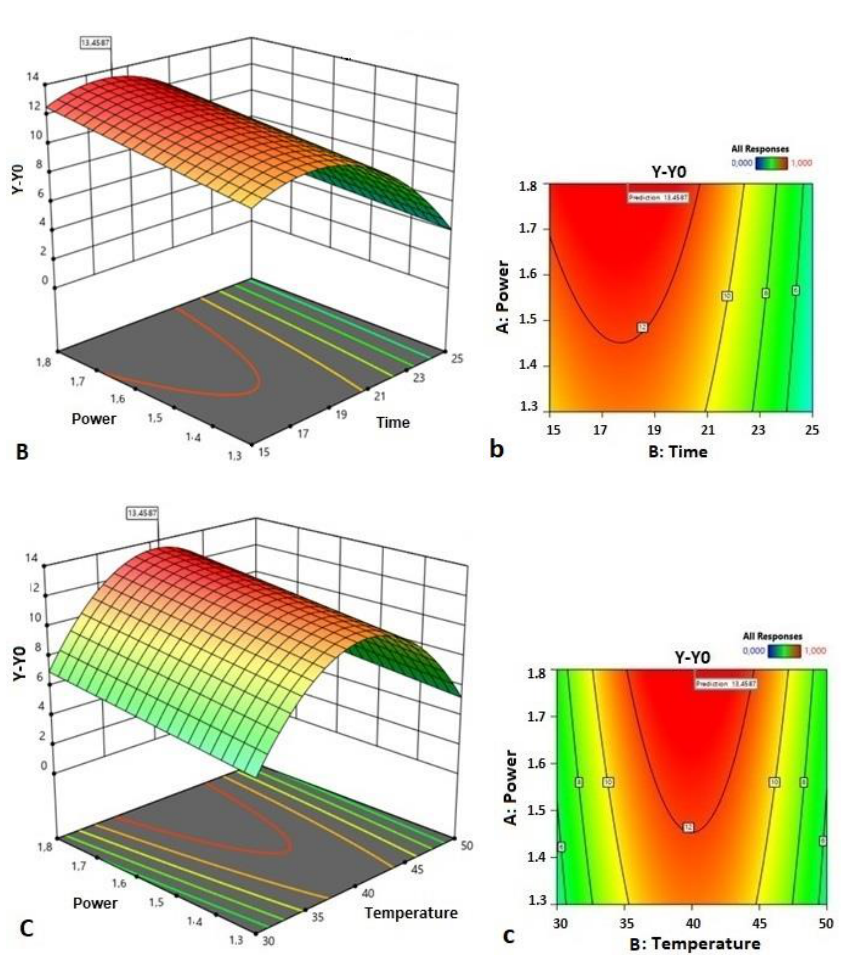
Figure 2. Response surface plots ( A – C ) and contour plots ( a – c ) of the interactions between ultrasound temperature and time ( A ), power and time ( B ), and power and temperature ( C ) for the RS increment (dY = Y − Y 0 ).